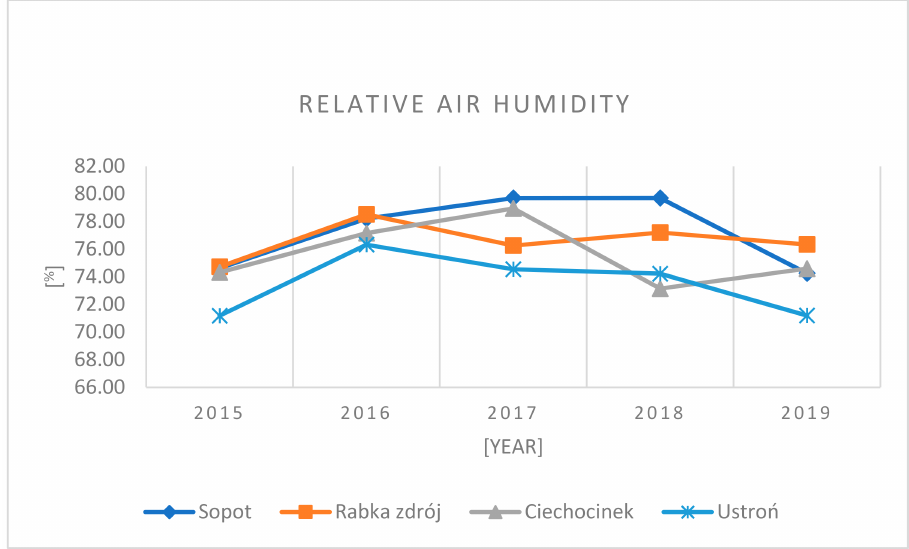
Figure 4. Average annual relative air humidity for health resorts in 2015–2019. The average visibility during the period considered in the health resorts of Ciechocinek was 20.96 km, and in Rabka Zdr ó j, 20.35 km (Figure 5). In 2018, these health resorts saw a positive growing trend of visibility, which may indicate a decrease in concentrations of harmful air pollutants. A sudden decrease in visibility was noticed in Sopot; in